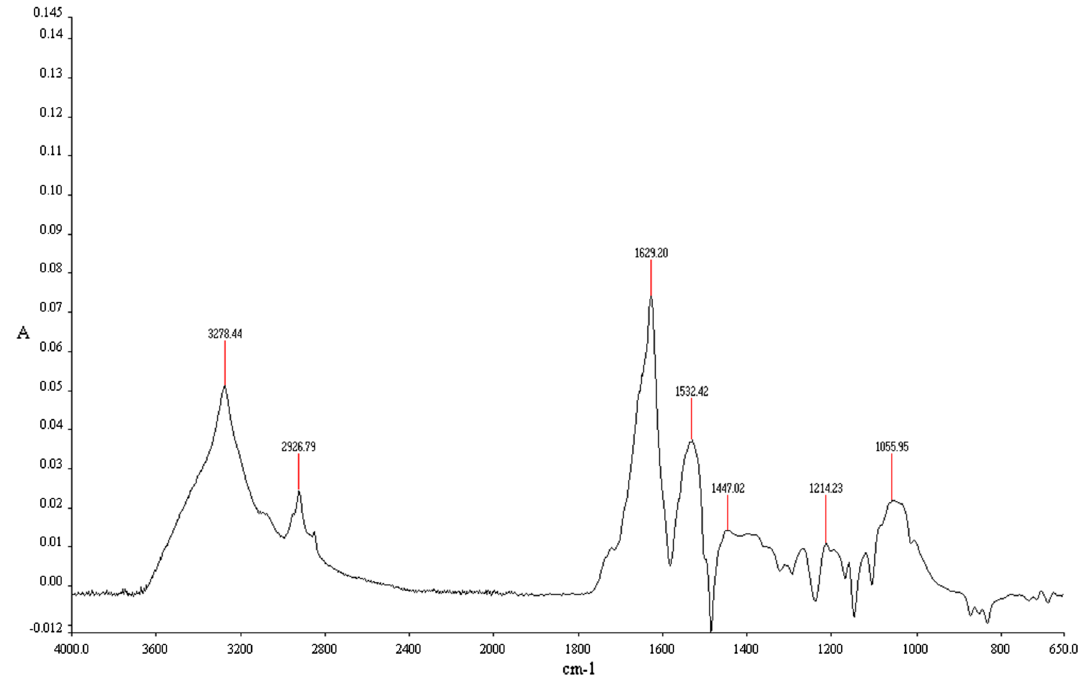
Fig. 12 Difference ATR/FTIR spectra of Saehan